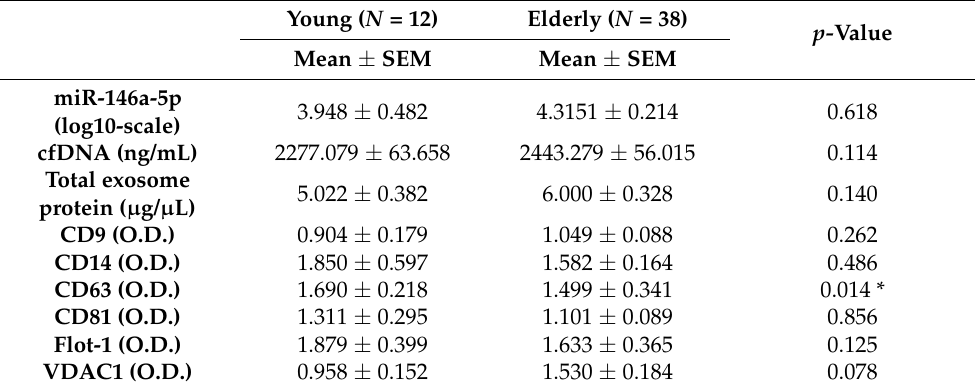
Table 3. The baseline levels of miR-146, cfDNA, and total exosome protein content between young and elderly groups.